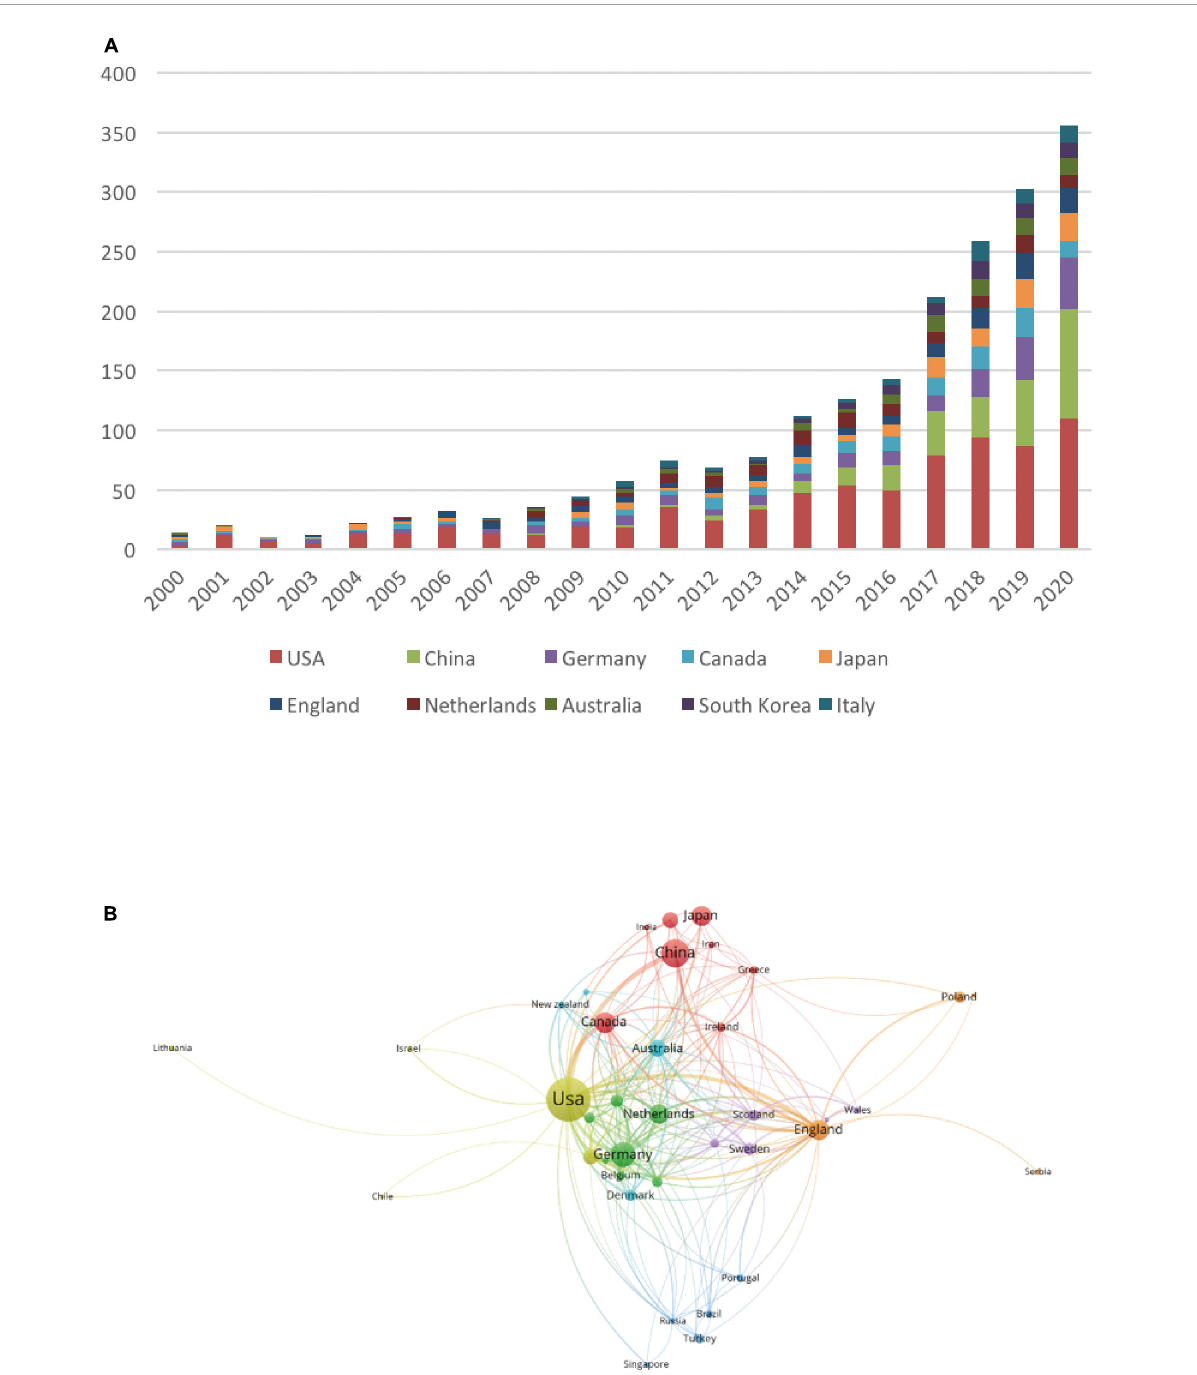
FIGURE2 The effect of changes in years and countries on the number of postoperative delirium (POD) articles. (A) The number of POD articles from the top 10 countries per year. (B) The network visualization map indicating collaborations between countries.